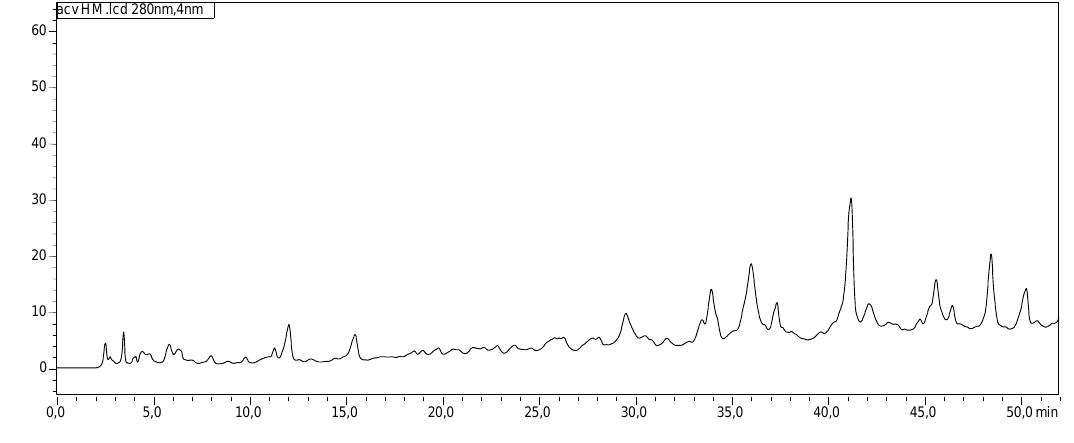
Figure 1. Representative high performance liquid chromatography profile of Adiantum capillus-veneris hydromethanolic